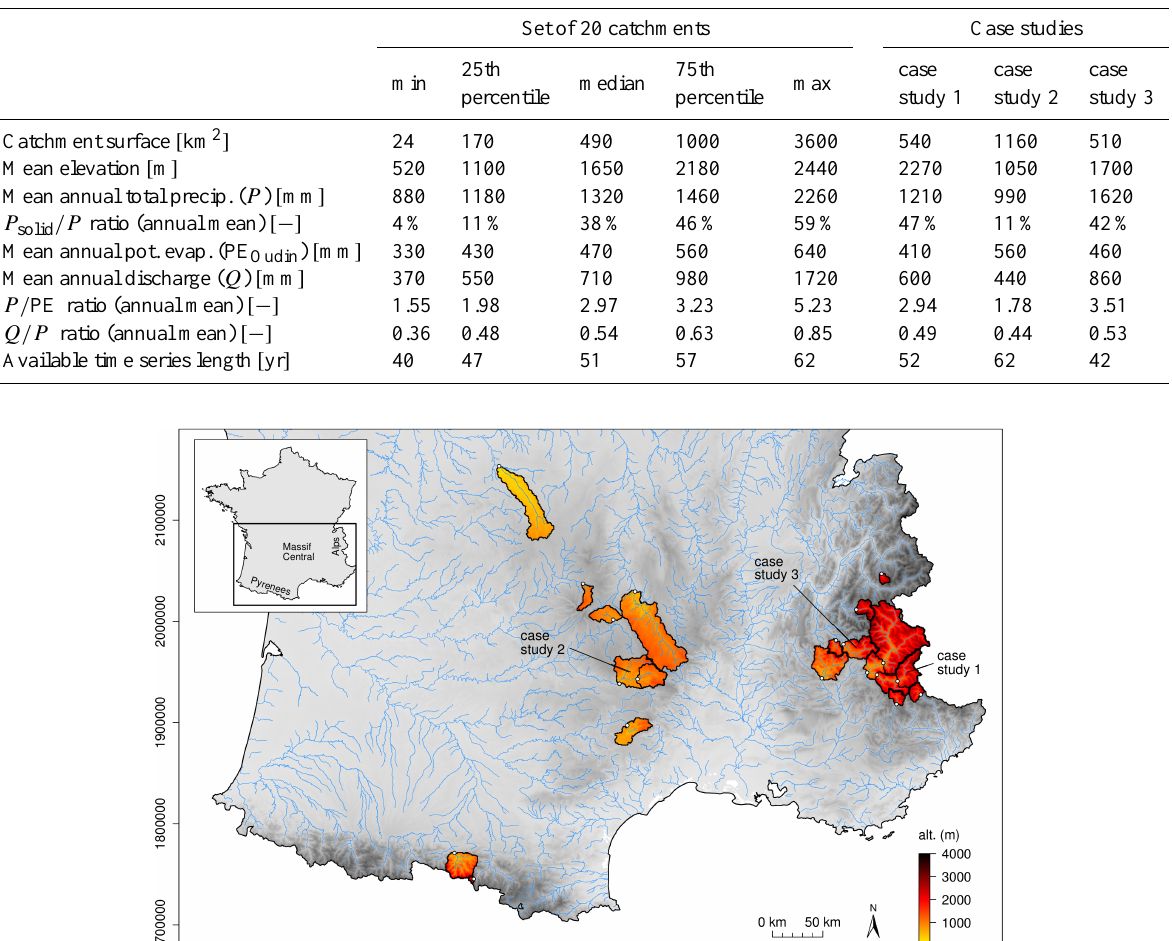
Table 1. Characteristics of the 20-catchment set and the three case studies.